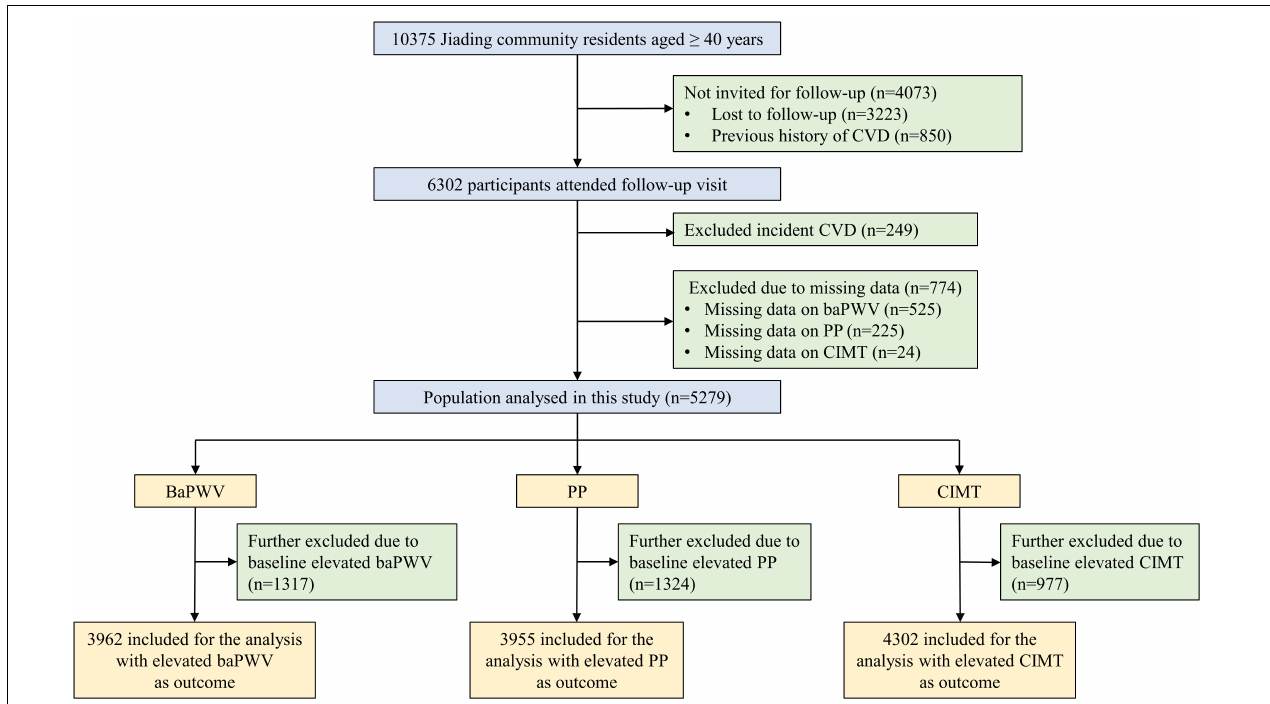
FIGURE 1 | Flowchart of study procedure. CVD, cardiovascular disease; BaPWV, brachial-ankle pulse wave velocity; PP, pulse pressure; CIMT, carotid intima-media